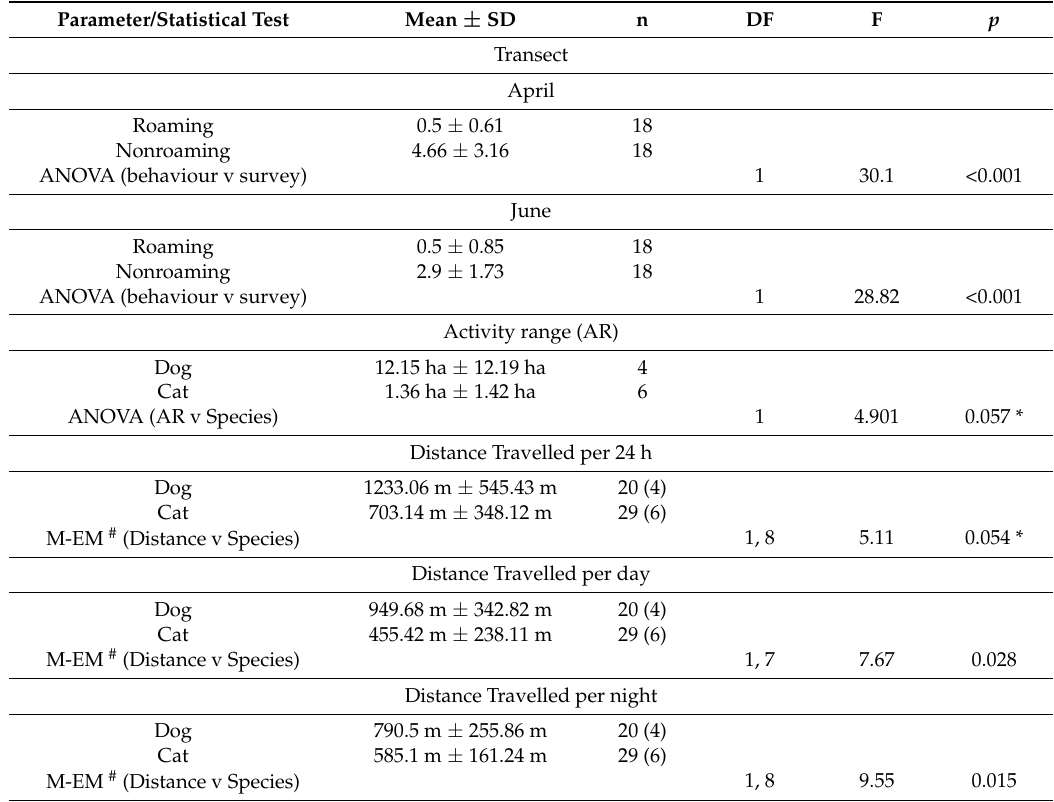
Table 2. Summary statistics for transect observations and GPS tracking. Transect observations are presented as the mean number of cats observed where n = number of transects and one-way ANOVAs on the effect of behaviour on the number of cats observed per transect. Activity Ranges (ARs) are presented as the average AR for dogs and cats where n = number of dogs and cats respectively and a one-way ANOVA on the effect of species on AR. Distance travelled is presented as the mean distance (metres) travelled per 24 h, per day and per night, where n = number of observations (number of collared animals) and mixed-effect models (M-EM) on the effect of species on the distance travelled. Parameter/Statistical